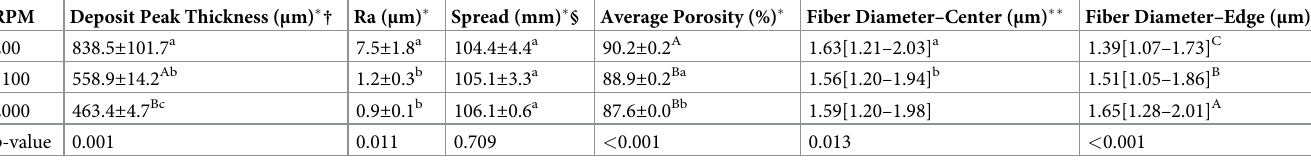
Table 1. Values of thickness, Ra, spread, porosity average, and fiber diameter.